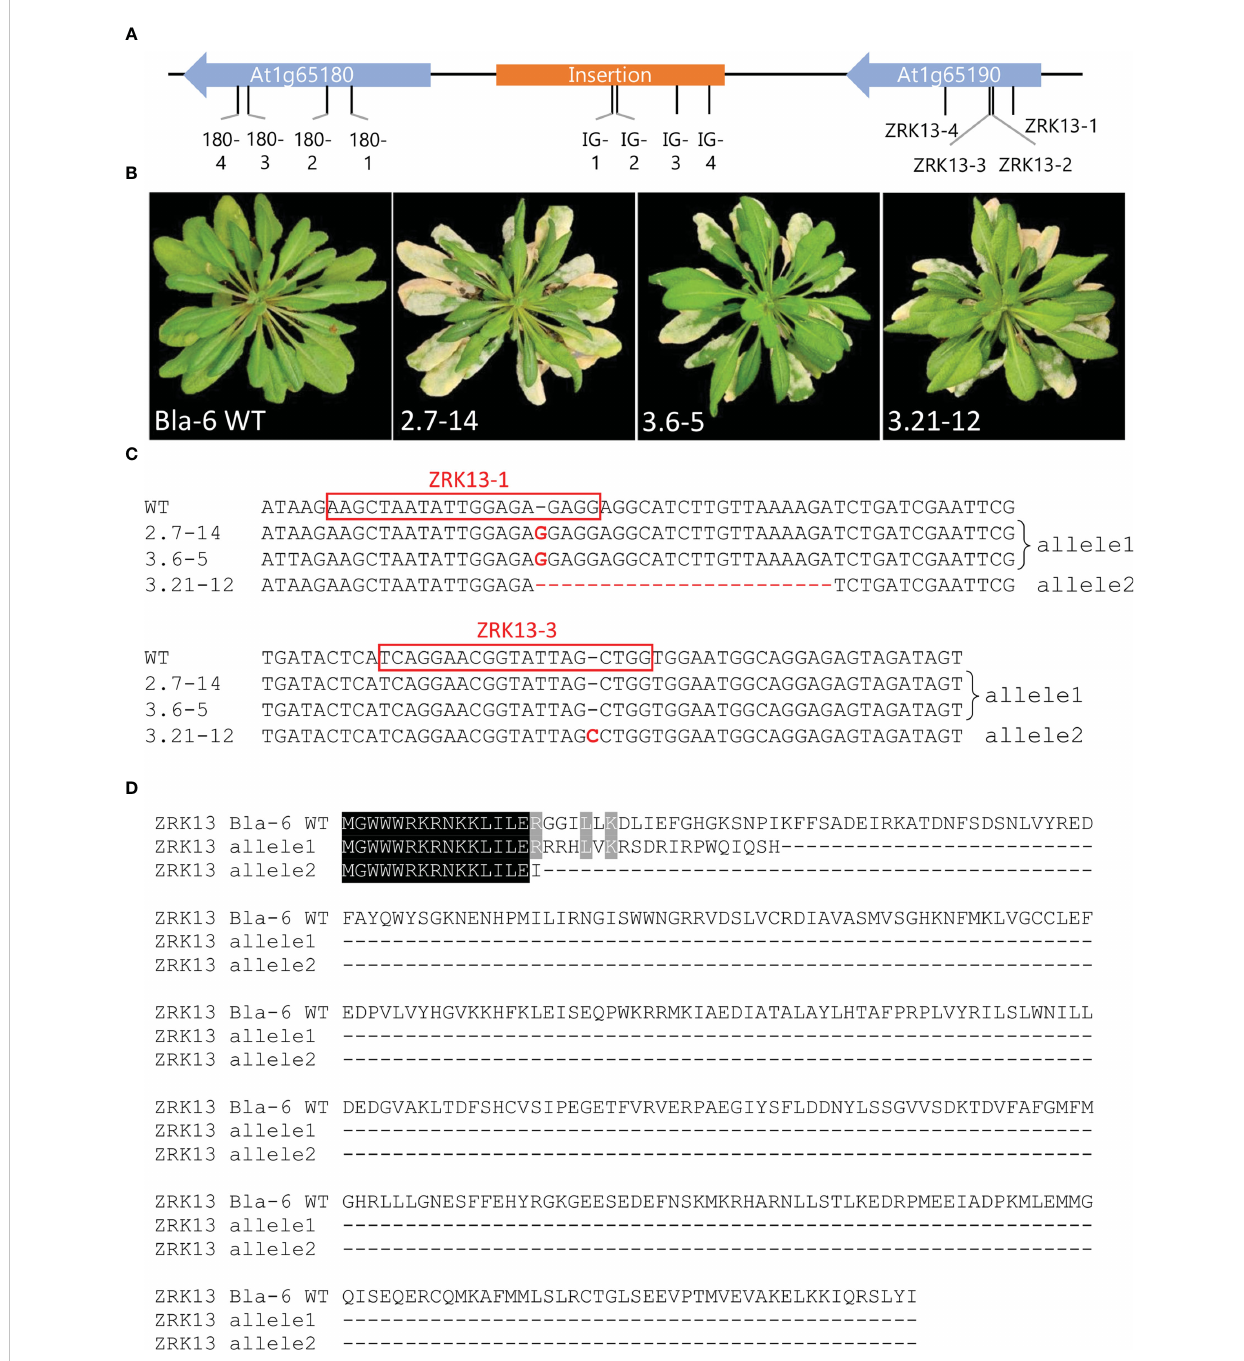
FIGURE 2 Targeted mutagenesis of ZRK13 in Bla-6 results in a susceptible phenotype to Pseudoidium neolycopersici . (A) Location of the single guide RNAs (sgRNAs) in the candidate region of Bla-6. Blue arrows indicate the two genes in the region. Orange square indicates the insertion present in Bla-6. Black bars indicate the location of the sgRNAs. (B) Phenotype at 26 days post inoculation of wild-type (WT) Bla-6 and three T2 plants from susceptible ZRK13 CRISPR transformants. (C) Mutation events identi fi ed in the T2 plants shown in (B) Deletions and insertions in CRISPR mutants are indicated with letters in red. sgRNAs ZRK13-1 and ZRK13-3 are indicated inside red boxes. (D) Alignment of predicted proteins of ZRK13 CRISPR mutant alleles (shown in C ) compared with wild type (WT) allele of